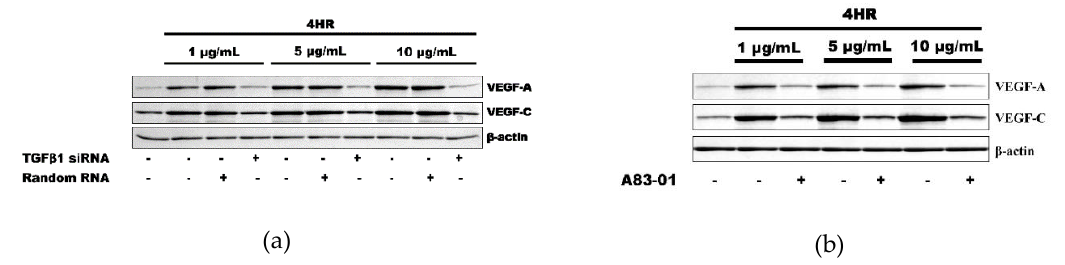
Figure 1. Western blot analysis. ( a ) The application of 4HR increased the expression of VEGF-A, VEGF-C, and TGF-β1. ( b ) The application of TGF-β1 also increased the expression of VEGF-A and VEGF-C. Full-length gels and blots are included in Figures S1 and S2.